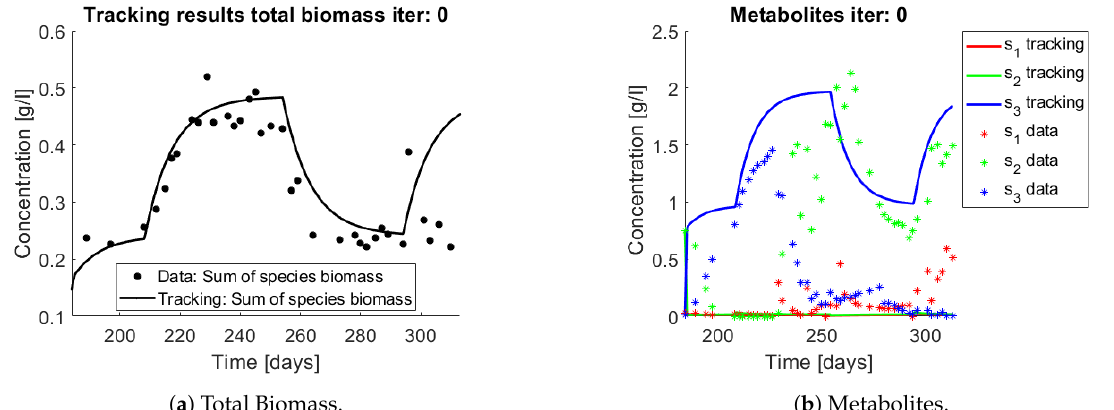
Figure 10. Simulation of system (25) when u = 1, with functions as in (27). Data points are represented by a star. The continuous line represents the simulation.